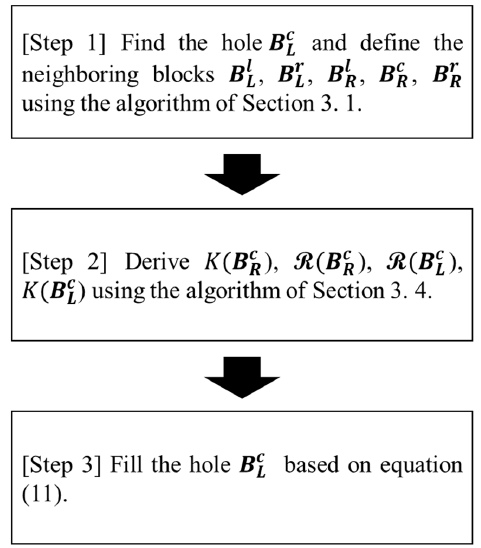
Figure 7. Flowchart of the proposed algorithm.